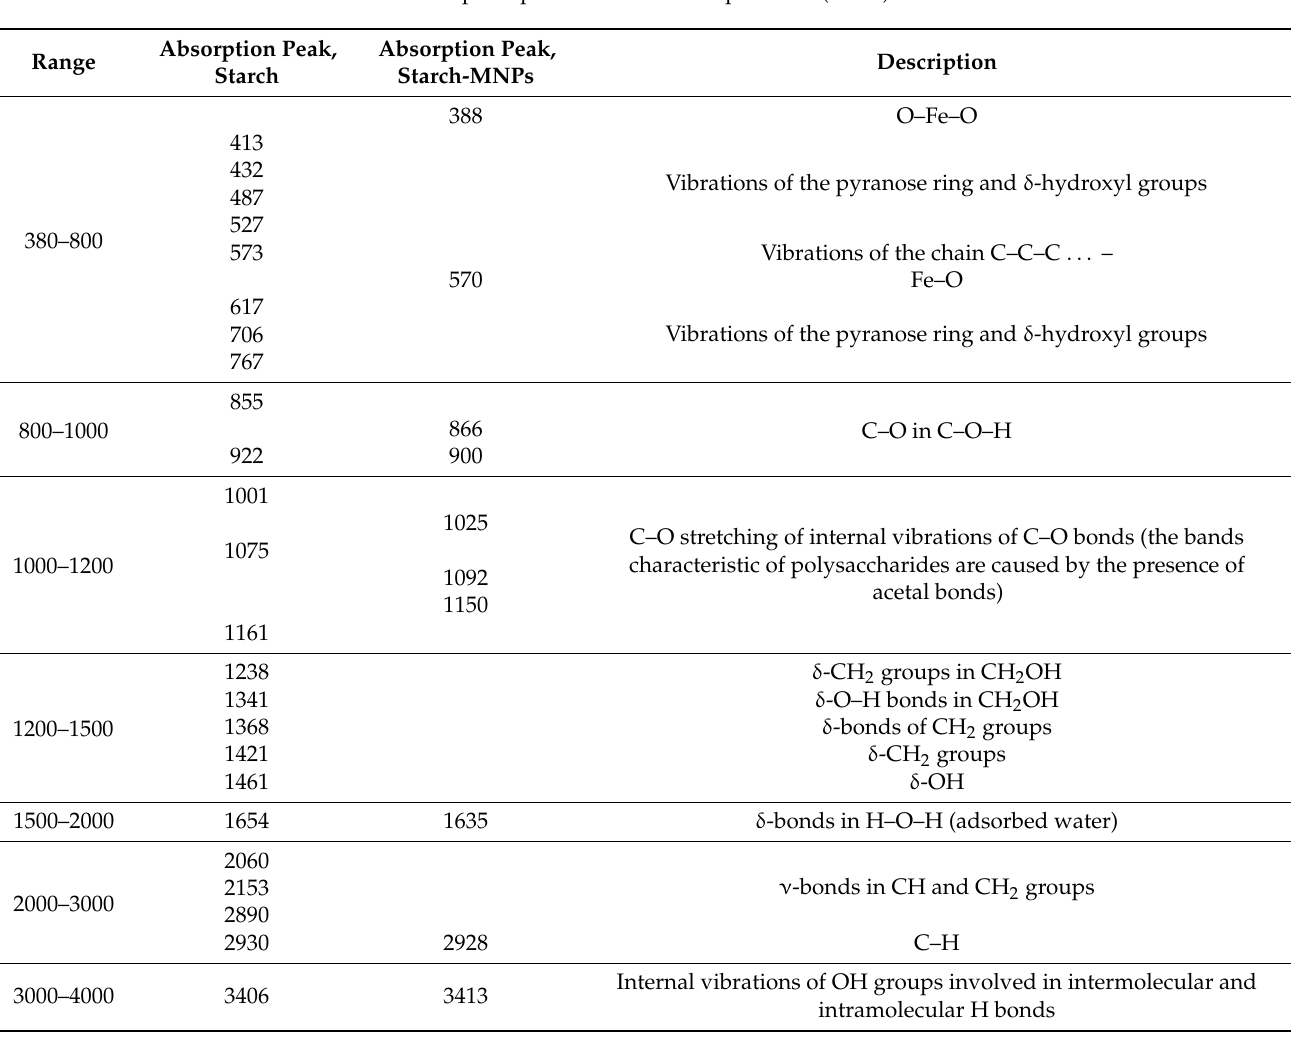
Table 2. Absorption peaks and their interpretation (cm − 1